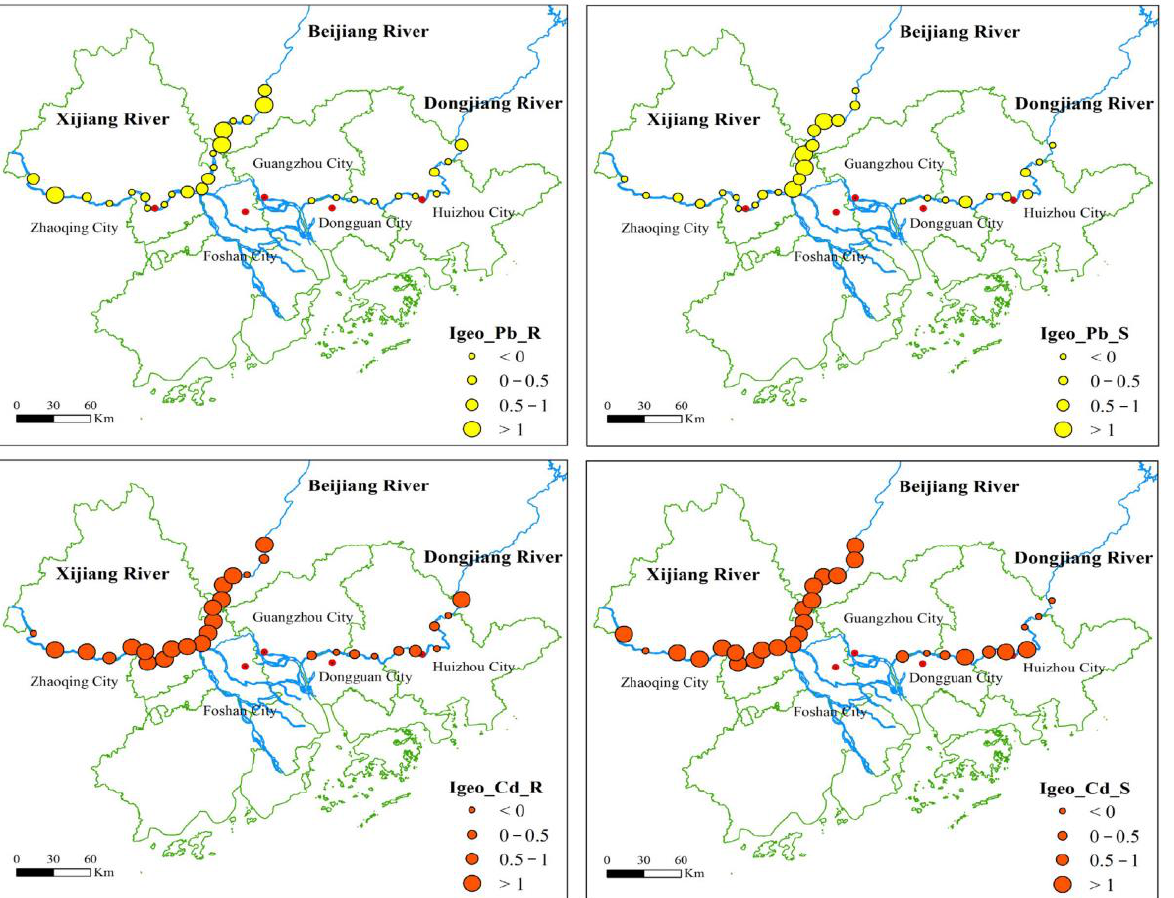
Figure 2. Spatial distribution characteristics of the geoaccumulation index of Pb and Cd in riparian soils and river sediments from three reaches. Note: Igeo_Pb_R and Igeo_Pb_S represent the geoaccumulation index of Pb from riparian soils and river sediments, respectively, and Igeo_Cd_R and Igeo_Cd_S represent the geoaccumulation index of Pb from riparian soils and river sediments, respectively.